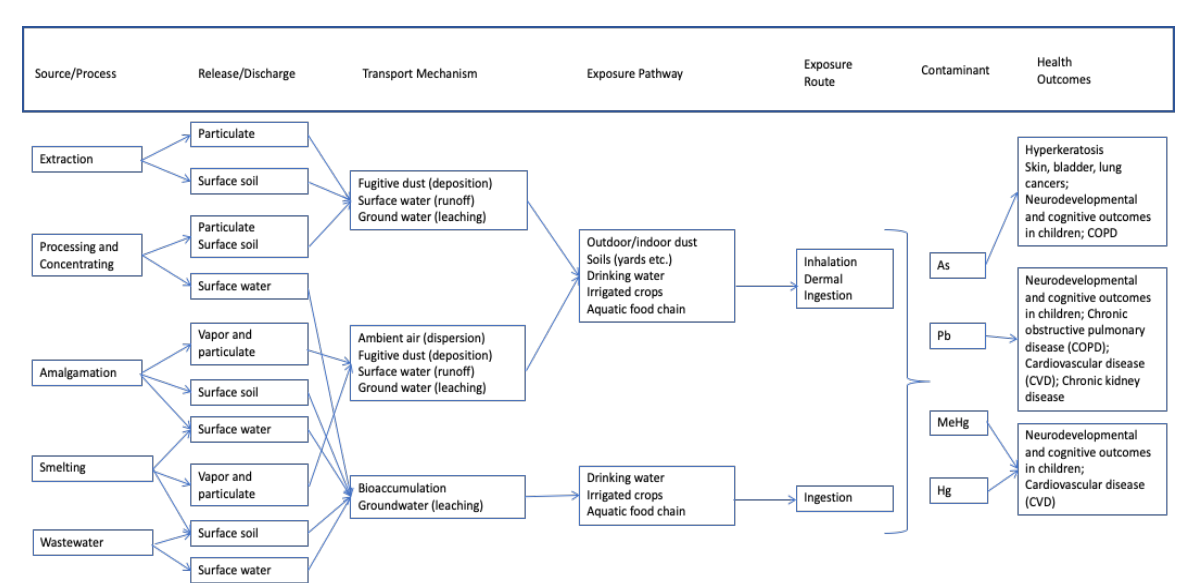
Figure 2. Generalized conceptual site model for artisanal scale gold mining activities.